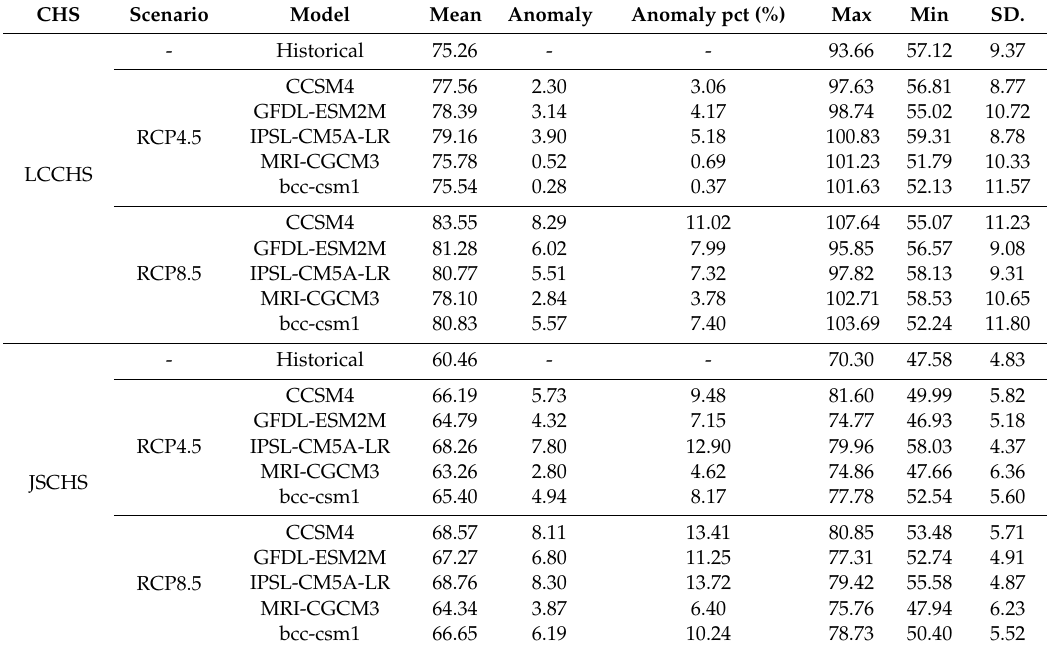
Table 5. The annual generation statistics under each projection and historical model simulation (unit: